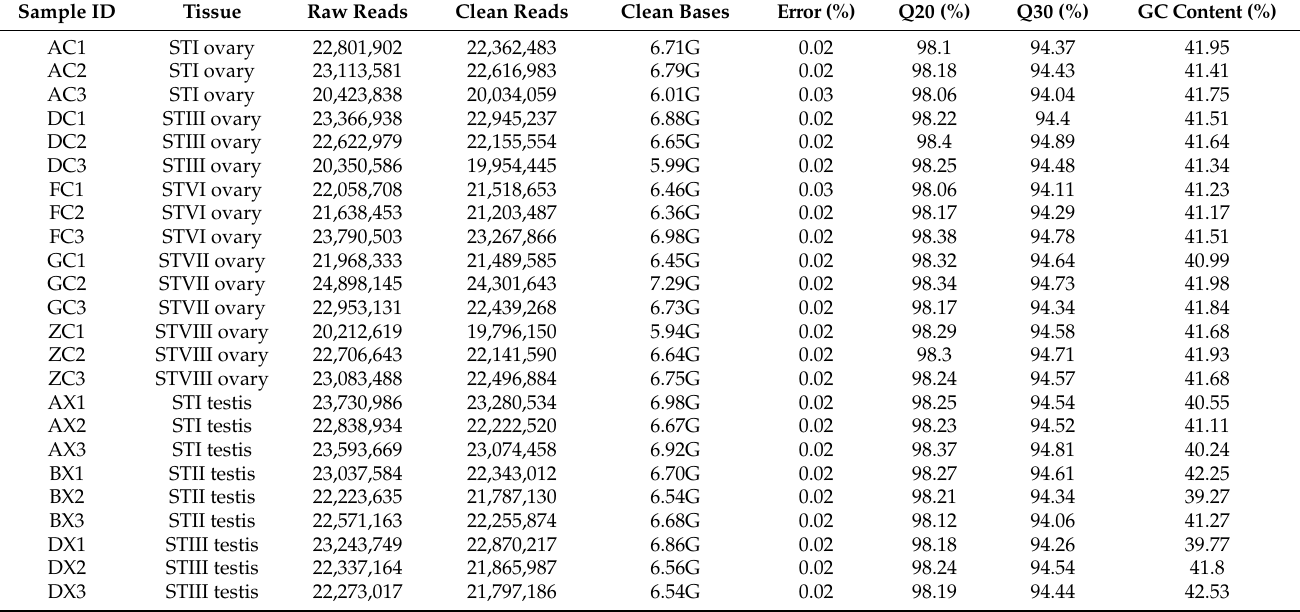
Table 2. Quality of transcriptome sequencing and assembly of the gonads in Macrobrachium rosenbergii